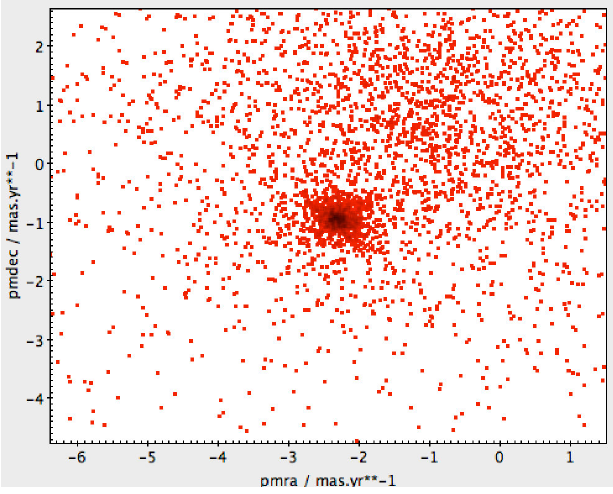
Fig. 64.— Zoomed-in proper motion plot of the region around NGC 188